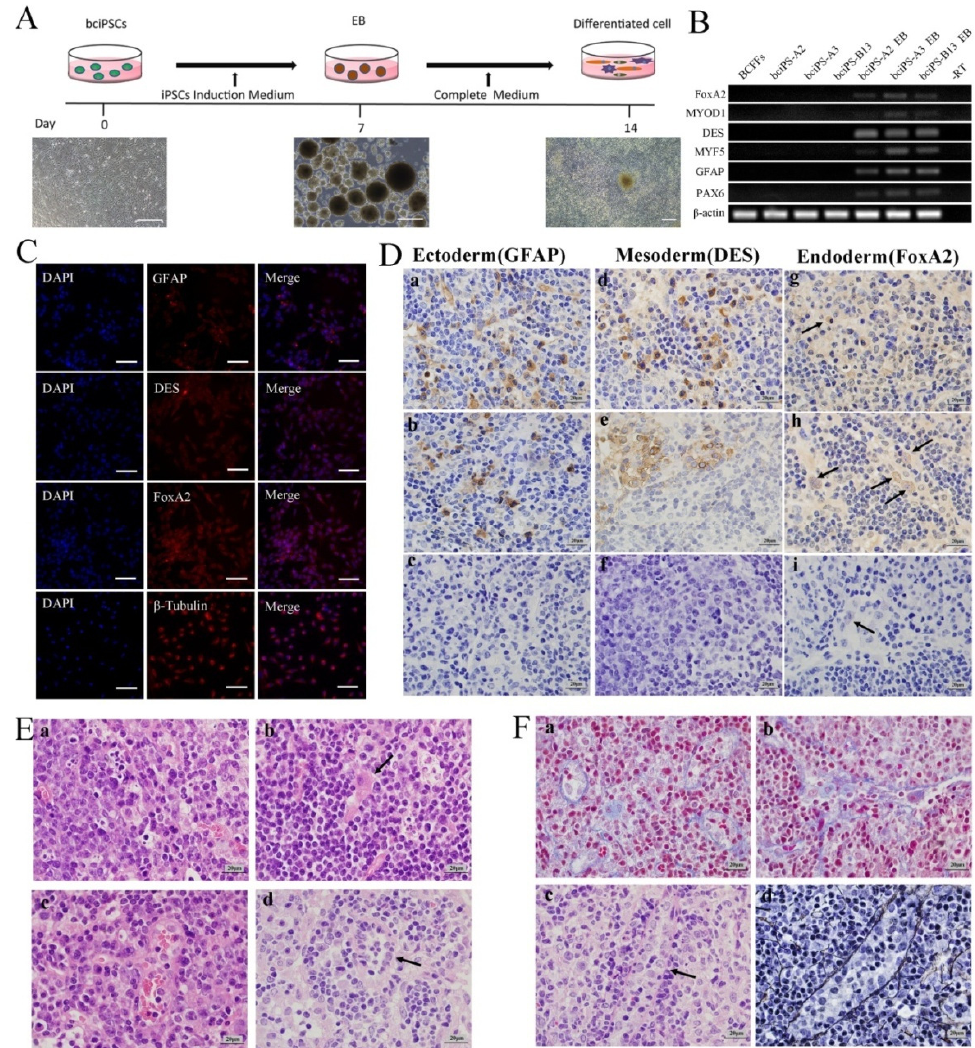
Figure 3. Embryoid body differentiation and teratoma formation. ( A ) flow chart of embryoid body formation and differentiation of bciPSCs; ( B ) PCR detection of bciPSCs and EB cells Germ layer gene expression; ( C ) immunofluorescence detection of three germ layer marker genes in EB cells, FoxA2 (endoderm), DES (mesoderm), GFAP (ectoderm) and β -Tubulin (reference gene) (20×, 50 μ m); ( D ) immunohistochemical results of teratoma (100×, 20 μ m), ( a , b ) GFAP (ectoderm). ( d , e ) DES (mesoderm), ( g , h ) FoxA2 (endoderm), ( c , f , i ) as the corresponding negative control; ( E ) HE staining results (100 × , 20 µ m), ( a ) proved to be the mitotic phase of the tumor, ( b ) nerve cells (ectoderm), ( c ) connective tissue (mesoderm), ( d ) glands (endoderm); ( F ) special histochemical staining for teratoma (100 × , 20 µ m), ( a , b ), collagen fiber staining (blue), ( c ) reticular fibers under HE staining, ( d ) reticular fibers stained